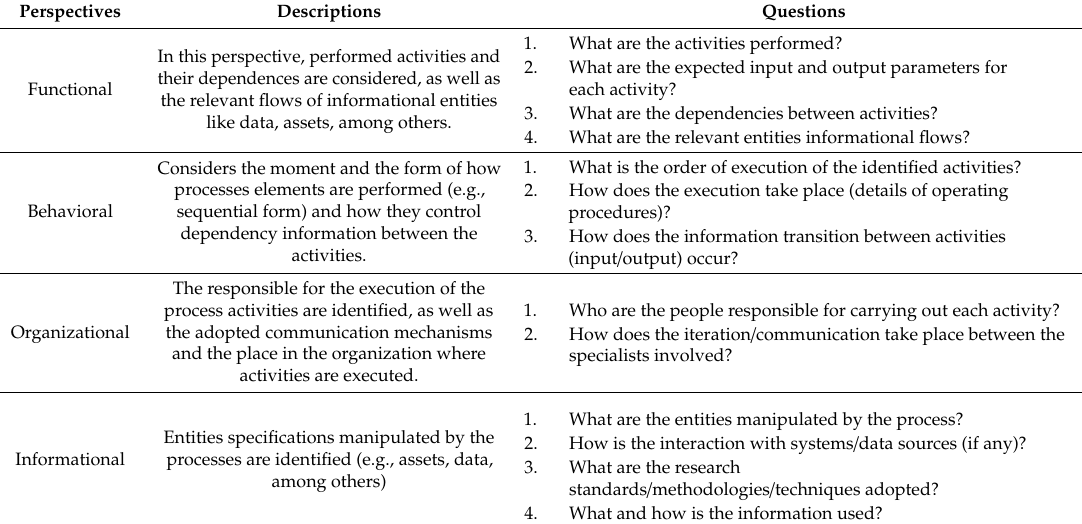
Table 6. Perspectives adopted for information extraction and adopted questions